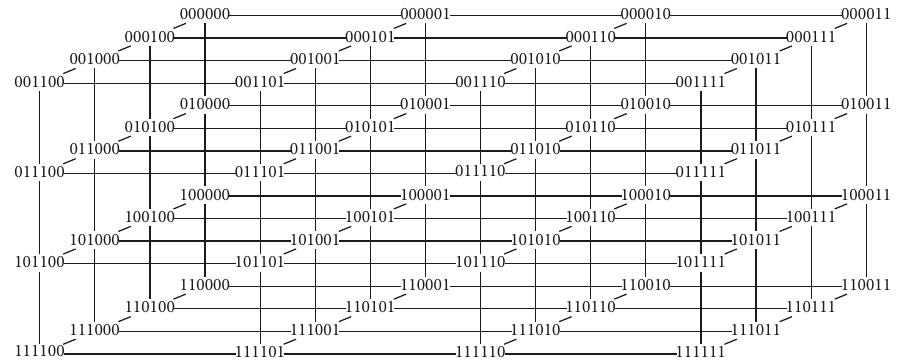
Figure 3: Cube of order 4 in base 2.